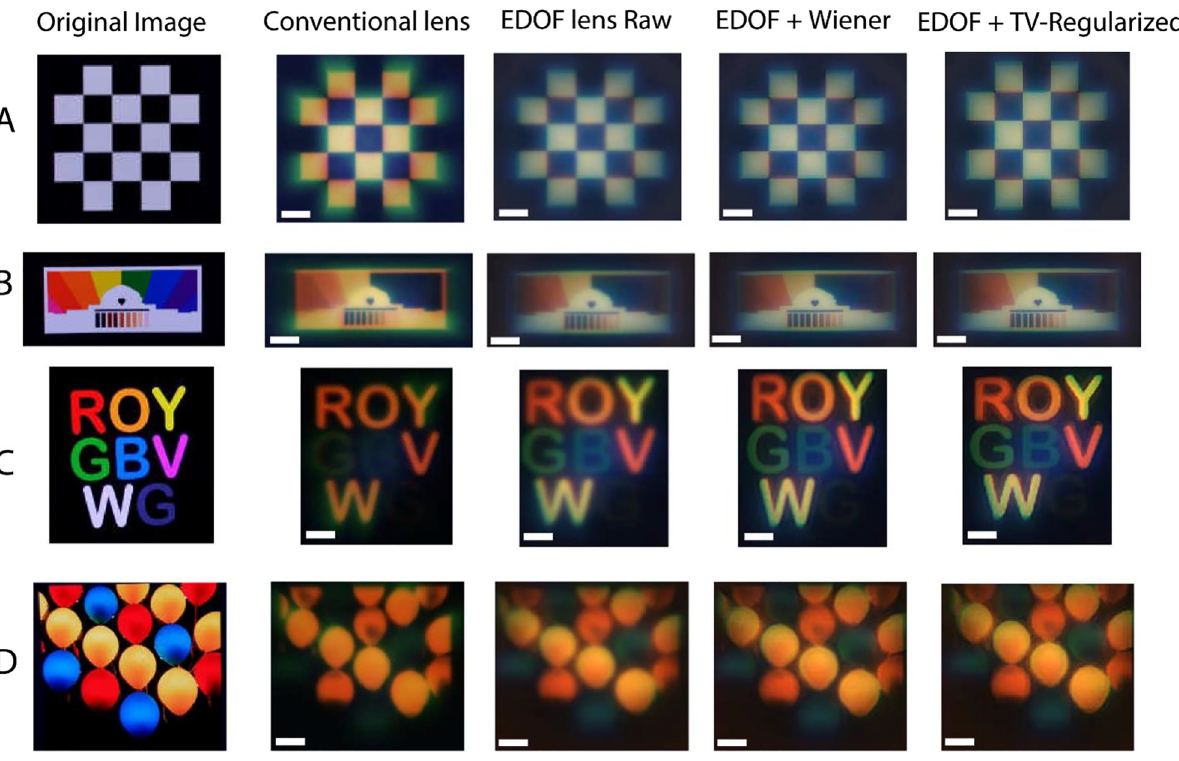
Figure 4: White light imaging. Images were taken from an OLED display of (A) white-black cross pattern, (B) colored rainbow MIT pattern, (C) colored letters in ROYGBVWG, and (D)colorful fl oating balloons.The appropriately cropped original object patterns used for imagingare shownin the left column.The scale bars correspond to 100 μ